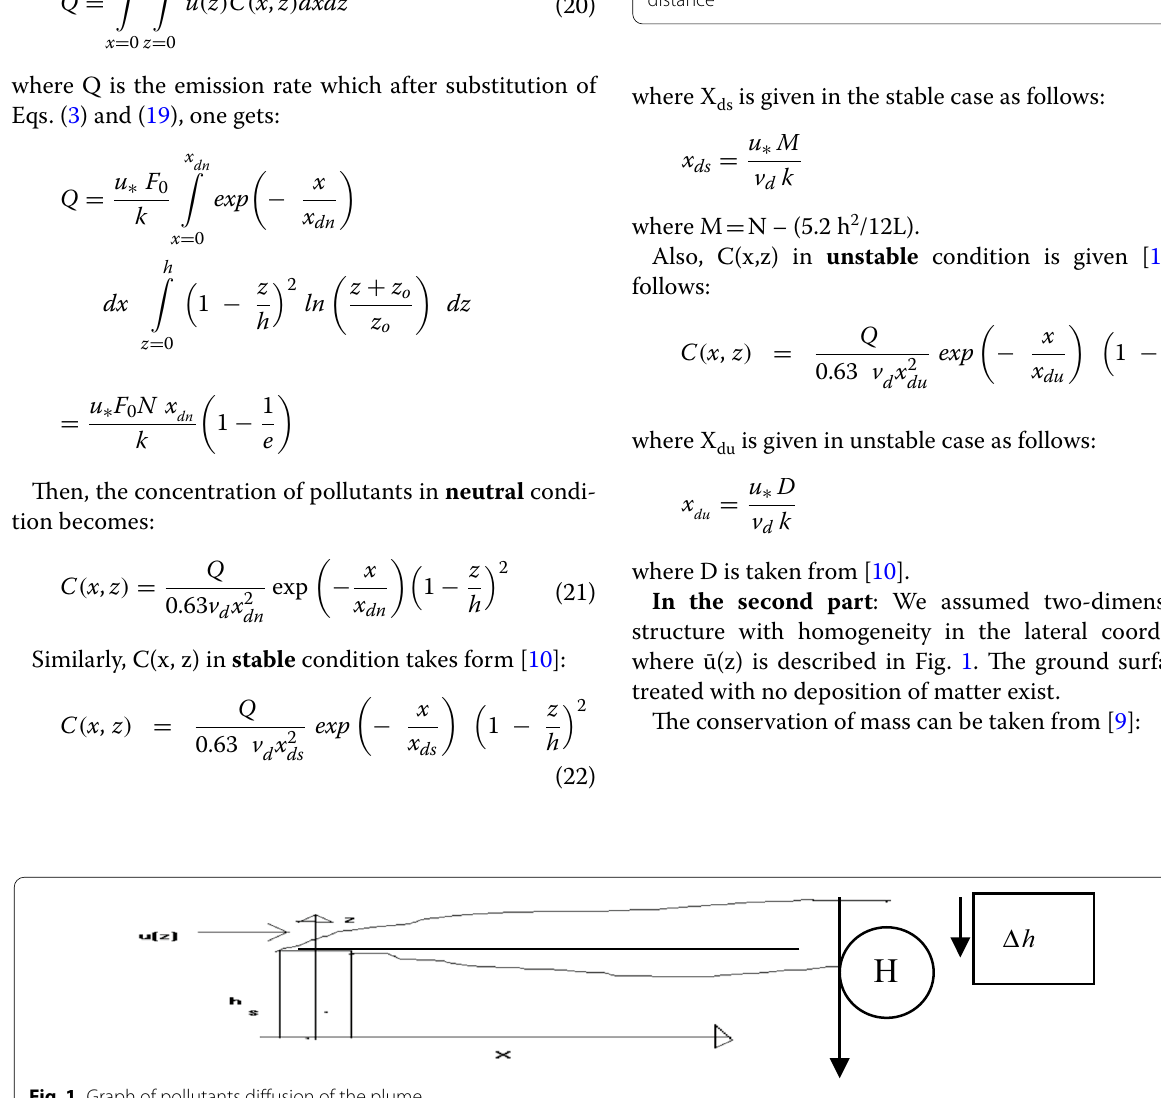
Fig. 1 Graph of pollutants diffusion of the plume